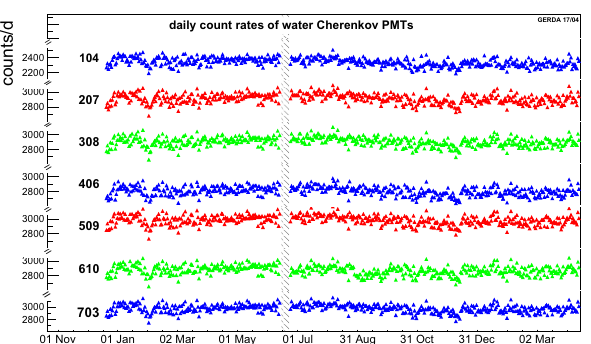
Fig. 29 DailyratesofwaterCherenkovPMTs, onefrom eachring(c.f. Ref. [41])